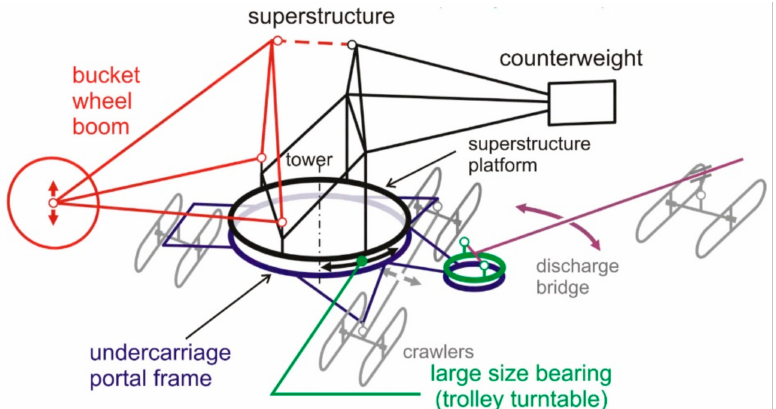
Figure 1. Schematic diagram of a large-scale heavy-duty machine (bucket-wheel excavator) mounted on a slewing